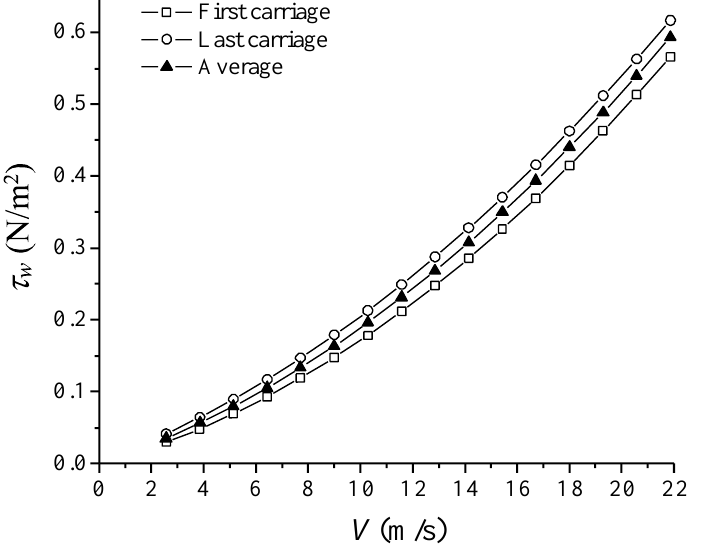
Figure 7. Dependence on the train speed V of the wall shear stresses τ wf measured on the first carriage, τ wl on the last carriage and their average τ wa in the recirculation mode.